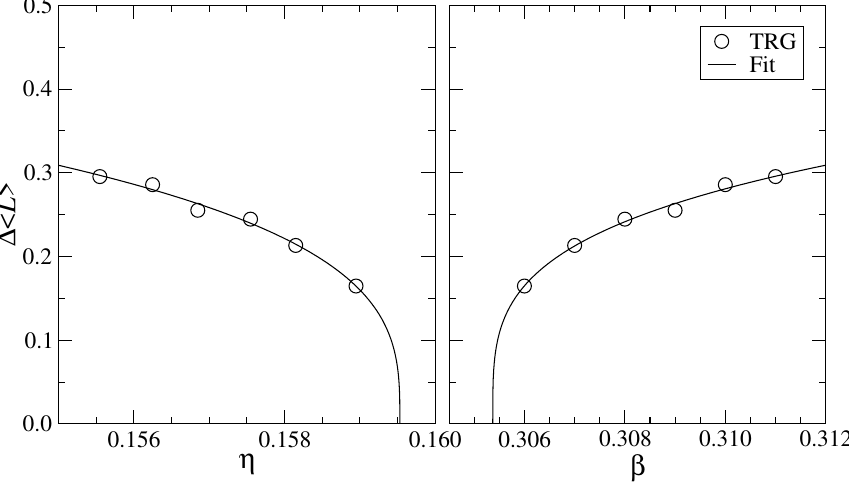
Figure 12 . (Left) Fit of ∆ h L i at µ = 1 as a function of η . (Right) Fit of ∆ h L i at µ = 1 as a function of β